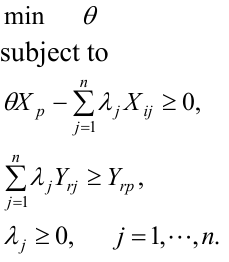
Number of successful attempts of purchasing goods Number of successful attempts to pay bills